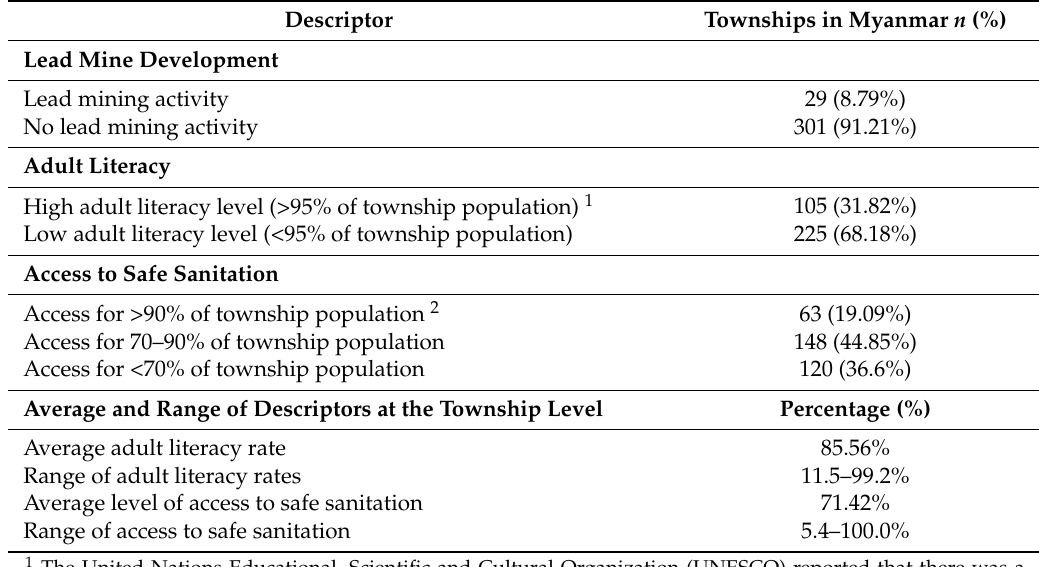
Table 1. Descriptive Characteristics of the Study Sample (Townships in Myanmar, n = 330).